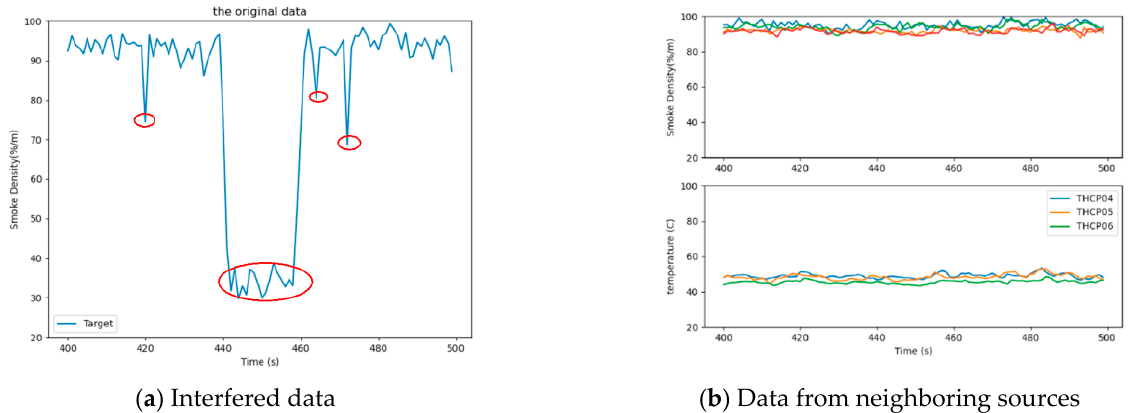
Figure 11. Data visualization. ( a ) Interfered data; ( b ) Data from neighboring sources. The data in red circles in Figure 11a are the artificially disturbed data. The remaining data are normal data. Figure 11b is the data from the adjacent sources.